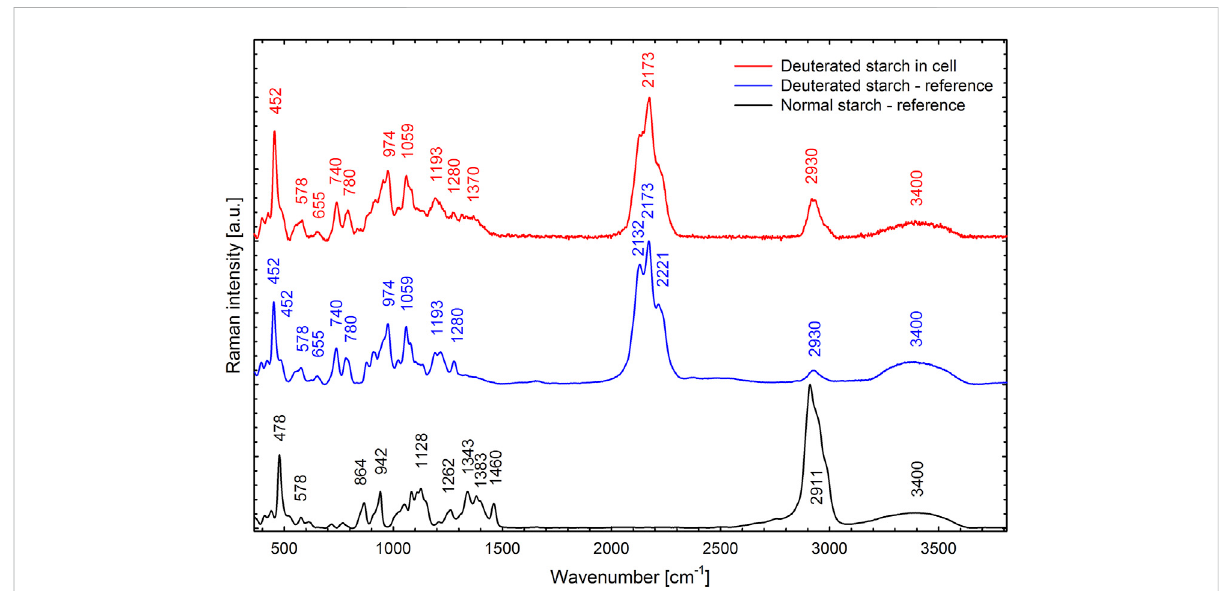
FIGURE 10 Raman spectrum of deuterated starch found in C. reinhardtii cells cultivated in the 90% D 2 O medium for 4 days (red line) compared with a reference spectrum of highly deuterated starch extracted from the C. reinhardtii culture cultivated in 99% D 2 O (blue line) and with a normal starch (black line). For all three specimens, the cells or starch granules were dispersed in H 2 O. Spectral contribution of H 2 O was subtracted and the background was